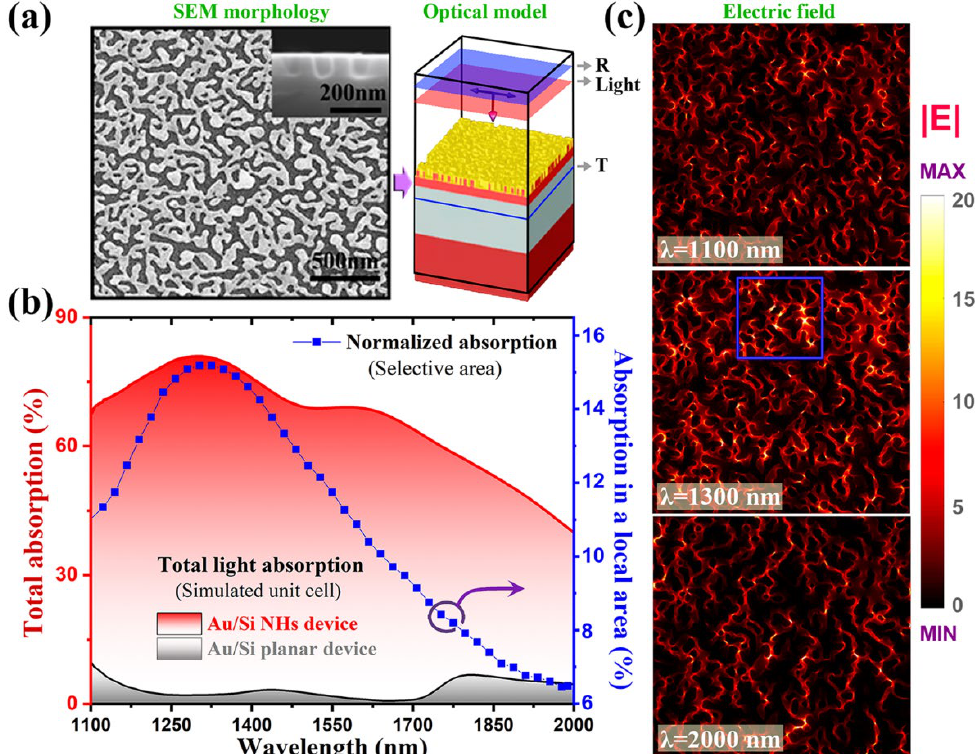
Figure 3. Three-dimensional optical modeling of the light absorption property of the Au/SiNHs structures. ( a ) Combining realistic morphologies with FDTD simulation. The simulated area is 2.5 × 2.5 µ m 2 . ( b ) Simulated absorption spectra of the nanostructured and planar Au/Si device. ( c ) Normalized electric filed distributions at three wavelengths. A hot spot area with high field intensities is marked with a blue frame and its corresponding absorption is plotted in ( b